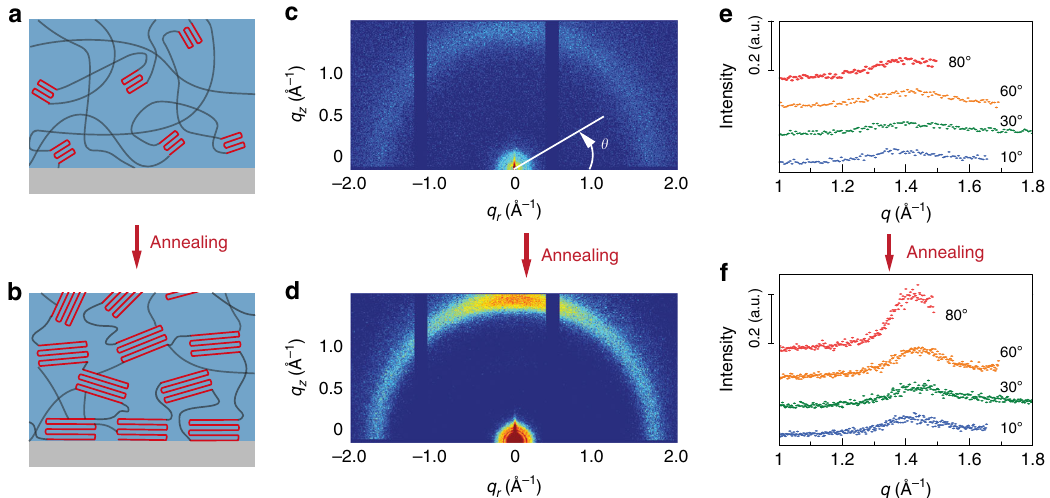
Fig. 3 Mechanisms for fatigue-resistant hydrogel adhesion from experiments. a , b Schematic illustration of the nanocrystalline structures of fatigue- resistant hydrogel adhesion before ( a ) and after ( b ) annealing (100 °C, 90 min). c , d GIWAXS patterns of fatigue-resistant hydrogel adhesion before ( c ) and after annealing ( d ). e , f GIWAXS scattering pro fi les at azimuthal angles of 10°, 30°, 60°, and 80° for PVA hydrogel before ( e ) and after ( f )